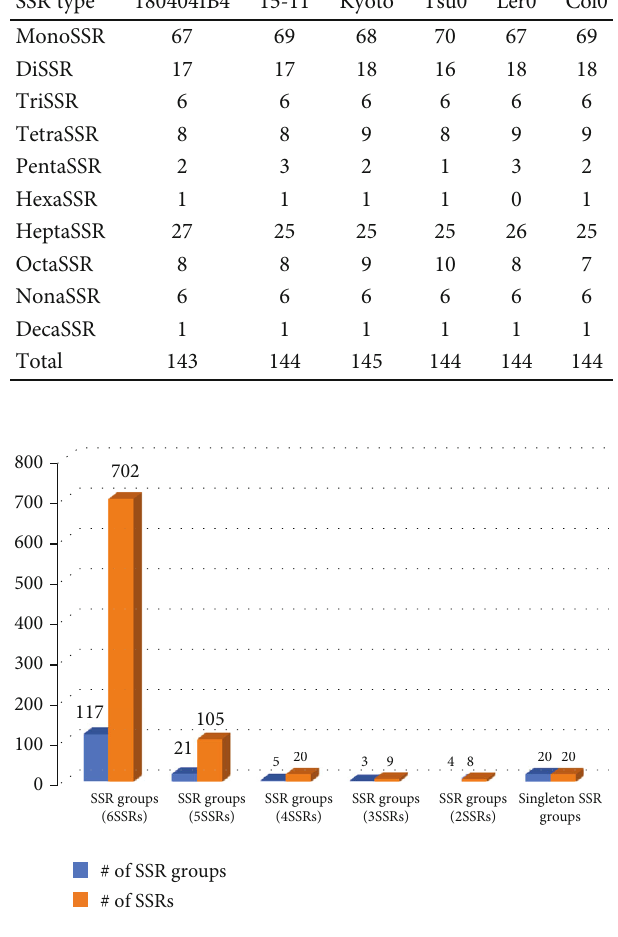
Figure 4: Distribution of the SSR groups identi fi ed from six chloroplast genomes of A. thaliana . X -axis indicates the types of the SSR groups and Y -axis means the number of the SSR groups or SSRs/extendedSSRs. Blue graph means the number of the SSR groups and orange bars mean the # of SSRs from the SSR